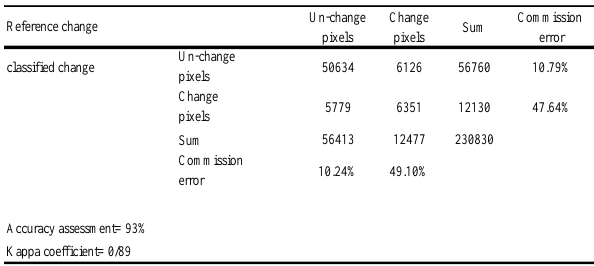
Table1. Kappa coefficient and Accuracy